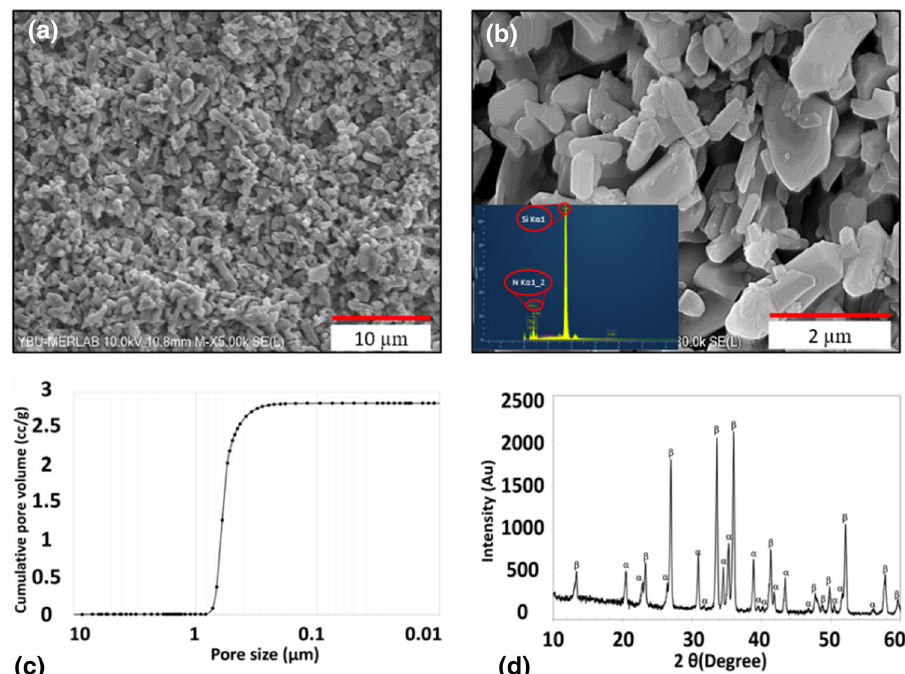
Fig. 2 SEM-SE images of Si ceramic at a 5000 × and b 30,000 × magnifications, c pore size distribution and d XRD pattern of Si